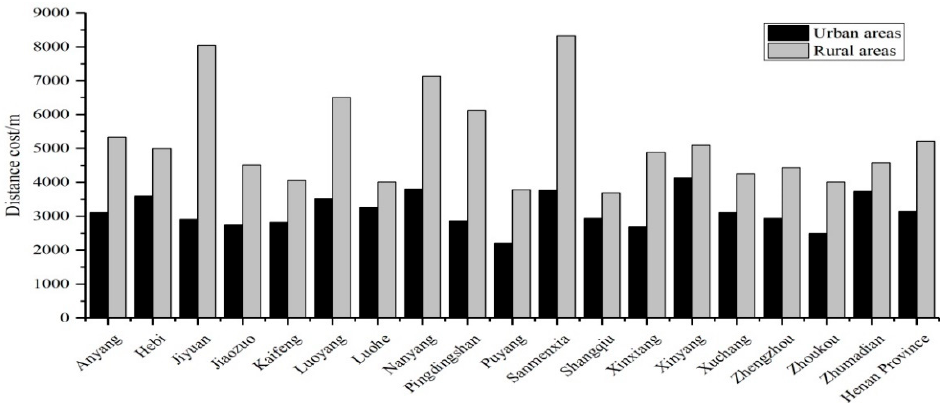
Figure 4. Differences in spatial accessibilities between urban and rural areas. Figure 4. Di ff erences in spatial accessibilities between urban and rural areas.